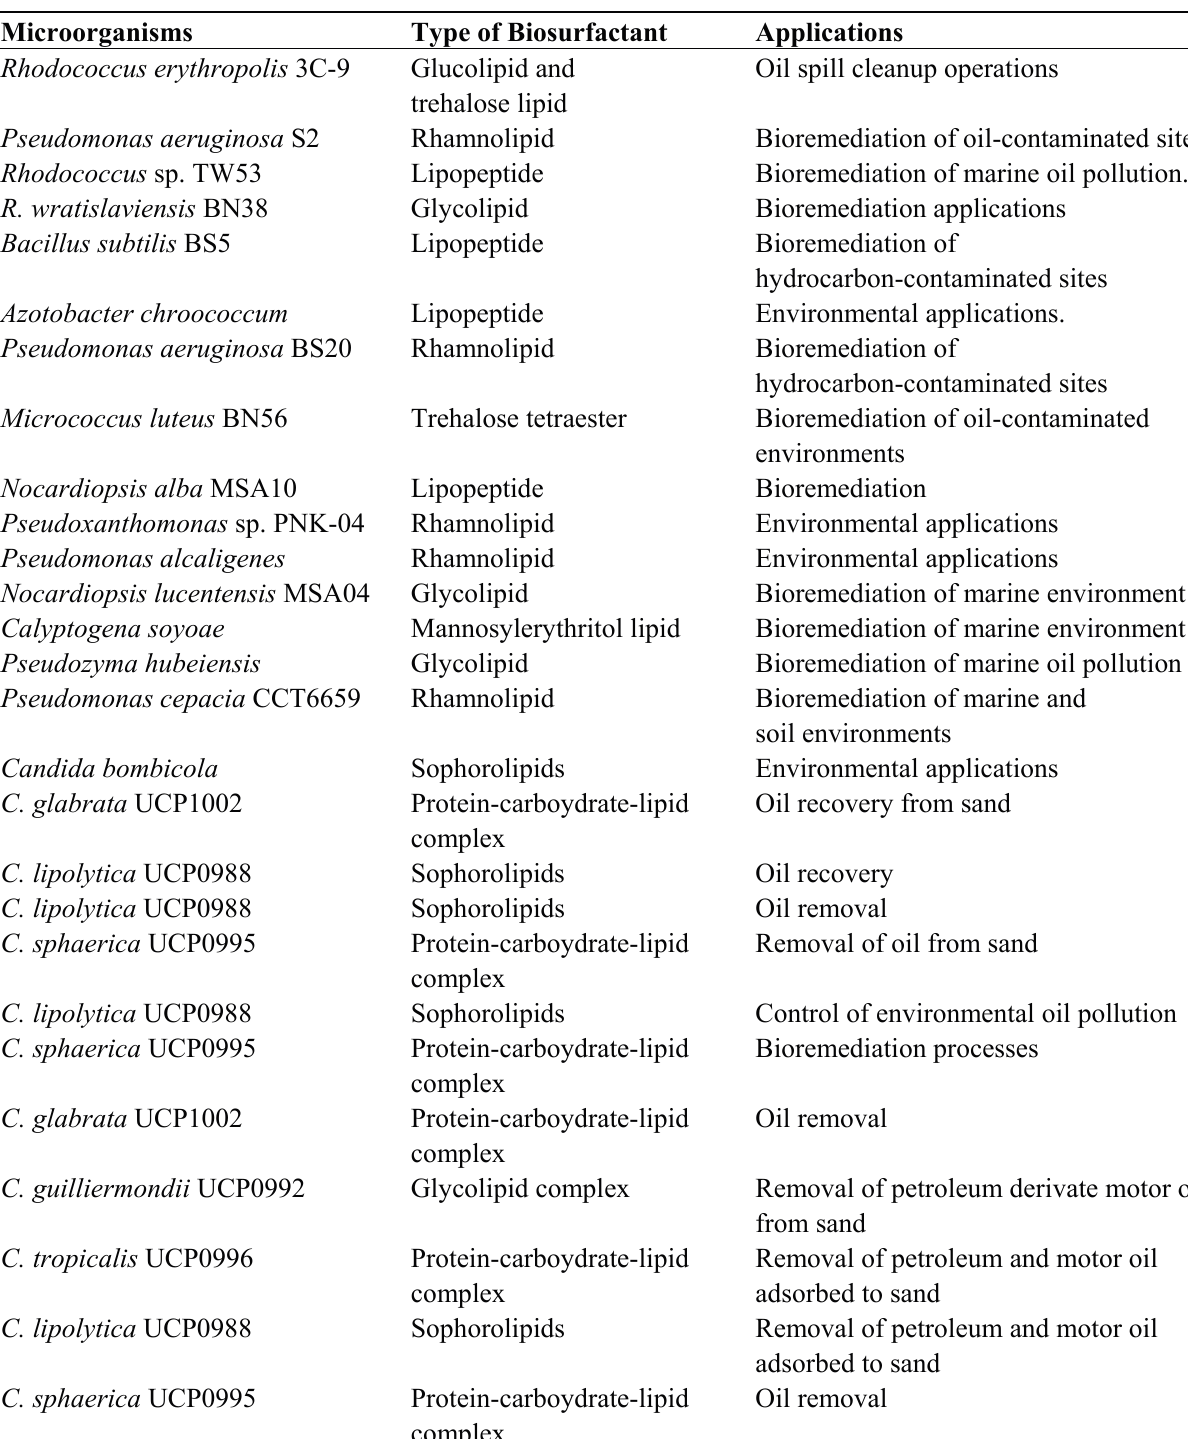
Table 4. Biosurfactants, producing microorganisms and uses in the bioremediation of oil-contaminated